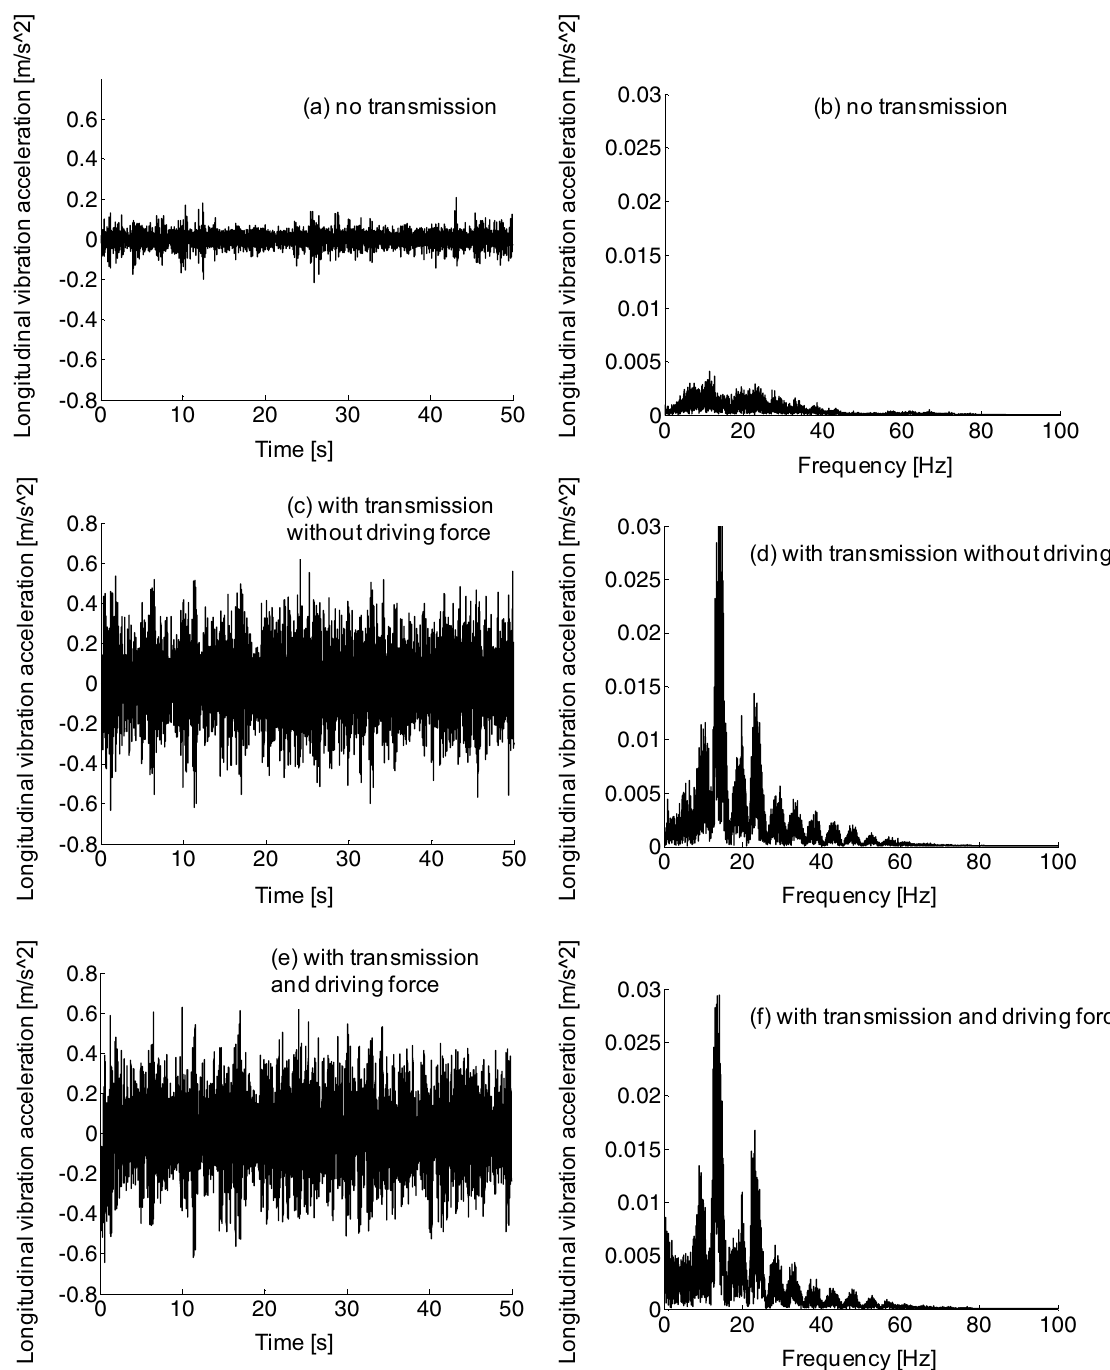
Figure 14. Car body longitudinal vibration acceleration, no transmission (a-b), with transmission without driving force (c-d), and with transmission and driving force